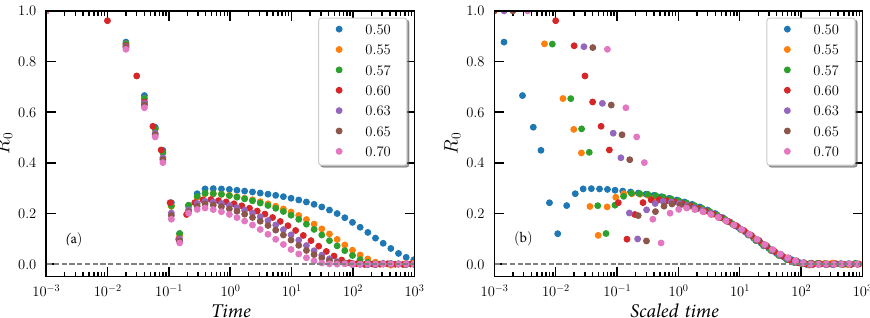
Figure 2. Test of time–temperature superposition for the normalized potential-energy time- autocorrelation function R 0 ( t ) at the temperatures indicated in the legends: ( a ) shows the simulation data and ( b ) shows the same data empirically scaled on the time axis. We conclude that TTS applies except at the shortest